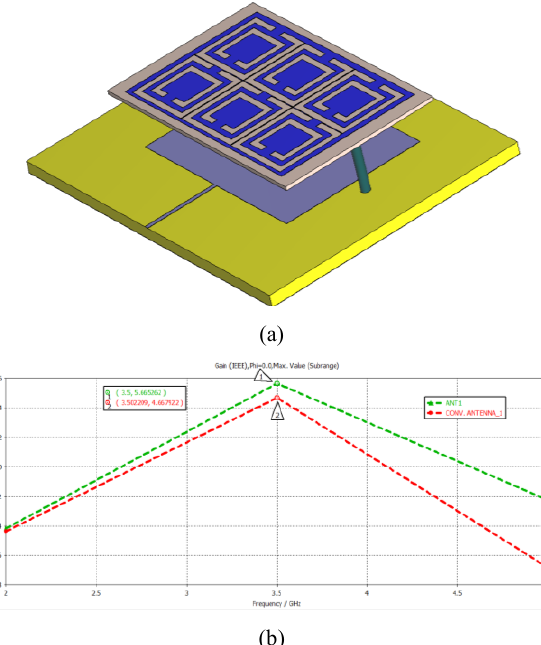
Fig. 4. (a) The geometry of the antenna with MTM, (b) the gain of the single patch microstrip antenna with and without